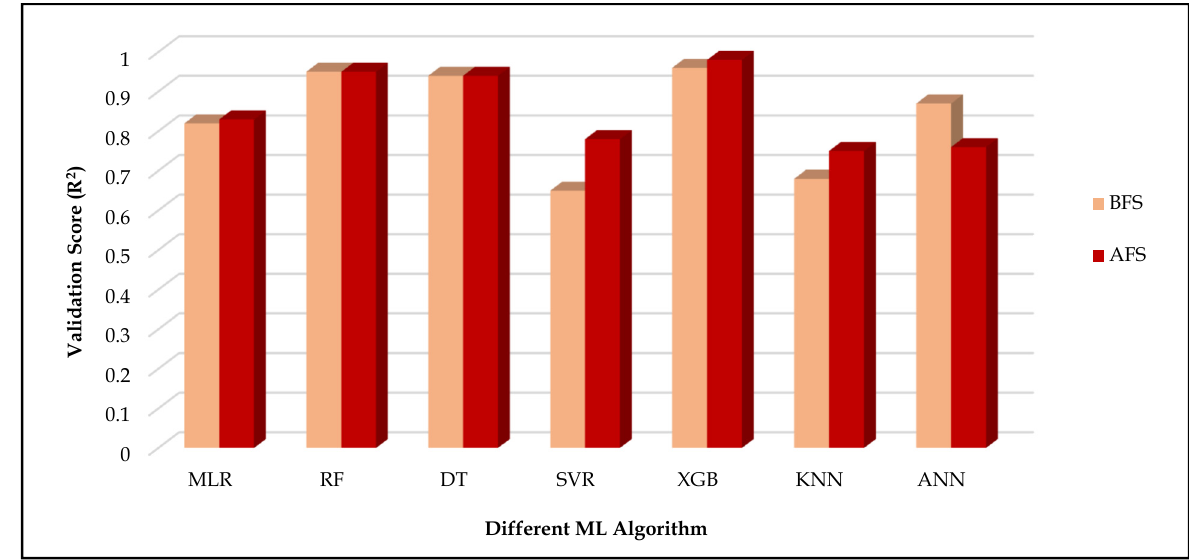
Figure 7. Comparison of validation (R 2 ) score for all ML models.